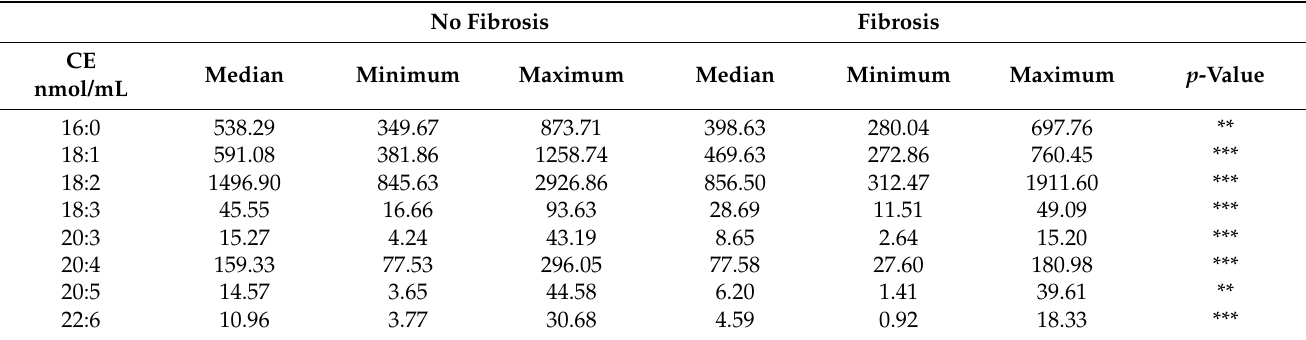
Table 3. CE levels in serum of patients with a low and a high FIB-4 score at therapy end. Only species which significantly differed between the two groups are listed. ** p < 0.01, *** p < 0.001.